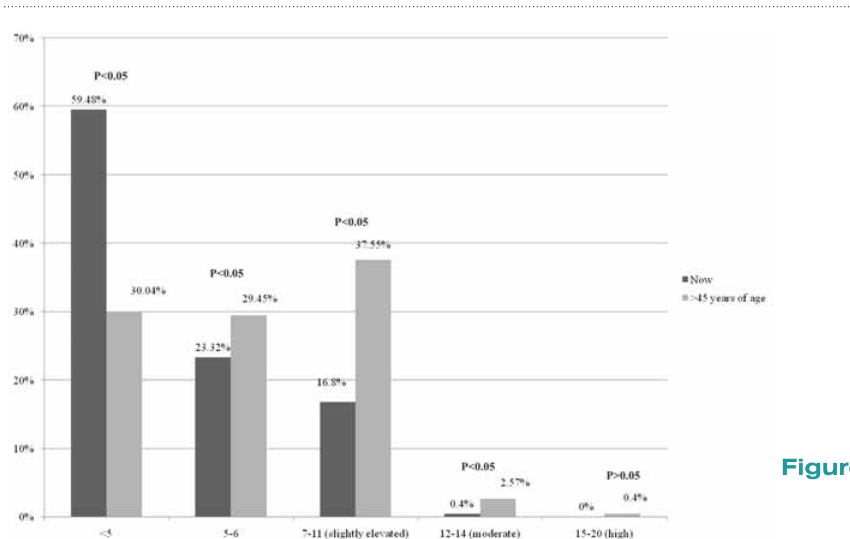
Figure 4. Predicted differences in the risk levels of diabetes mellitus type 2 over the age of 45 according to